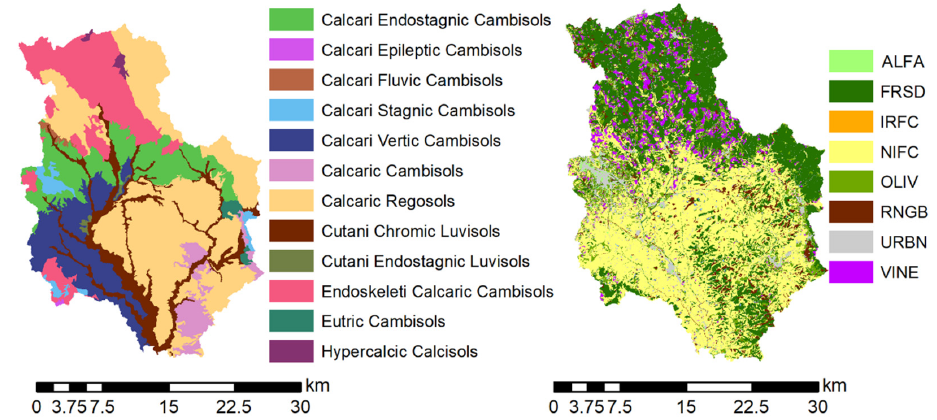
Figure 2. Pedological map (on the left ) and land cover map (on the right ) of the Arbia stream basin. The land cover classes were as follows: meadow (ALFA); broad-leaved forest (FRSD); irrigated field crops (IRFC); unirrigated field crops (NIFC); olive groves (OLIV); transitional woodland-shrub-brush (RNGB); artificial surfaces (URBN); vineyards (VINE).